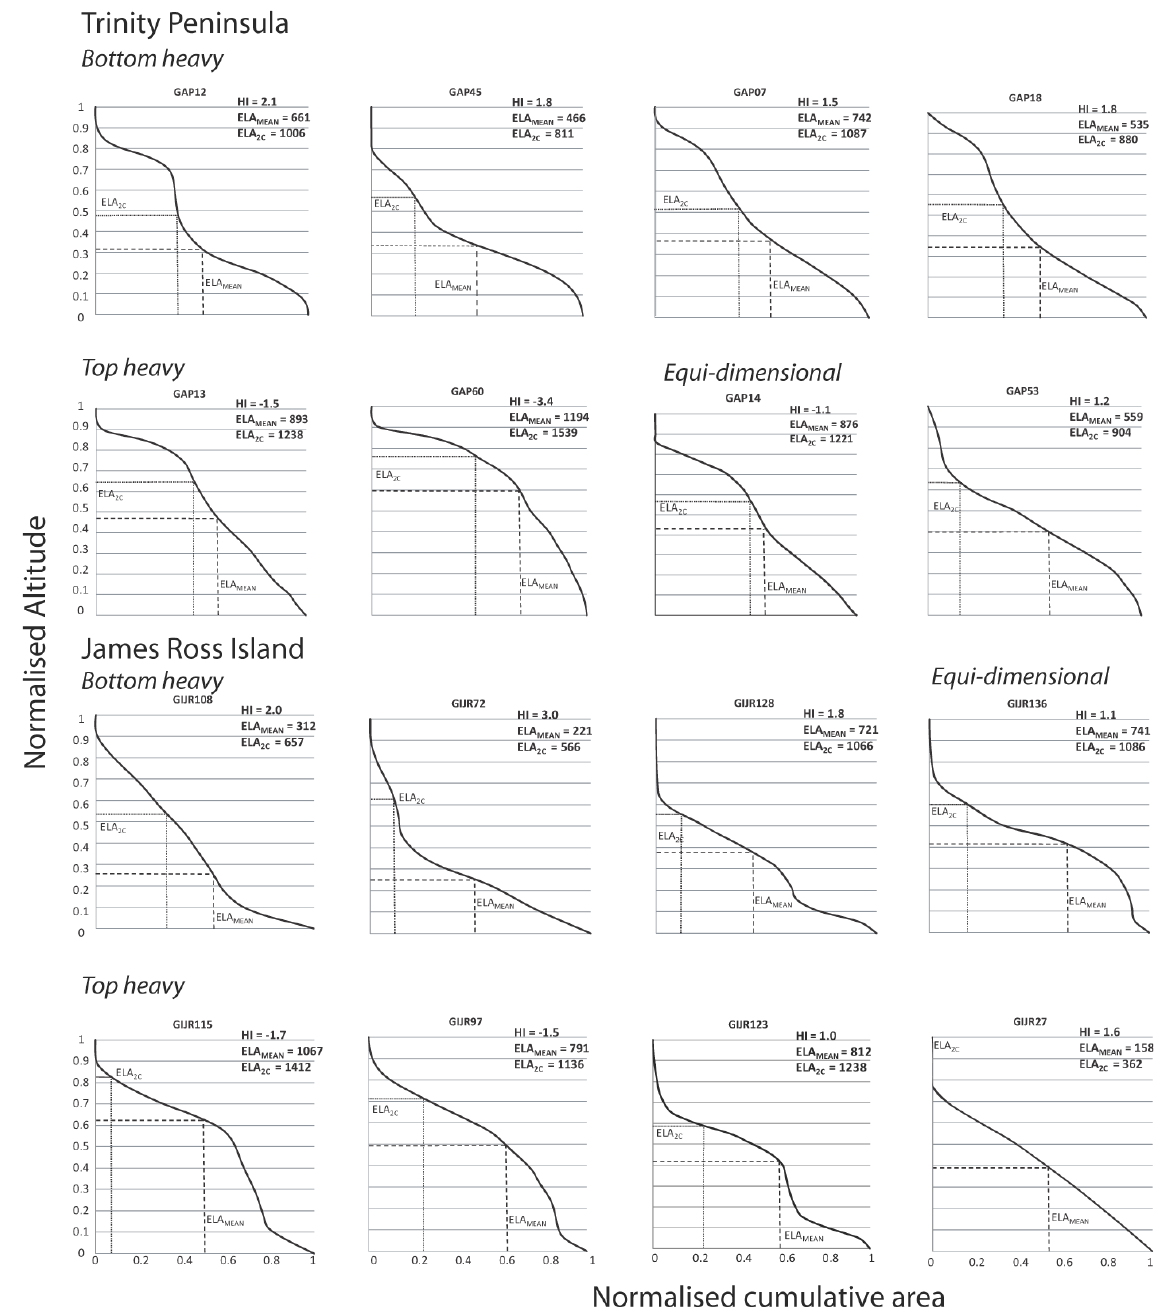
Fig. 4. Normalised hypsometric curves of representative tidewater glaciers on Trinity Peninsula and James Ross Island. Normalised ELA MEAN for each glacier is plotted. ELA 2C indicates the possible change in equilibrium line with future climate change. A 2 ◦ C warming could result (presuming an adiabatic lapse rate of − 5.8 ◦ C/1000m) in a rise in ELA of